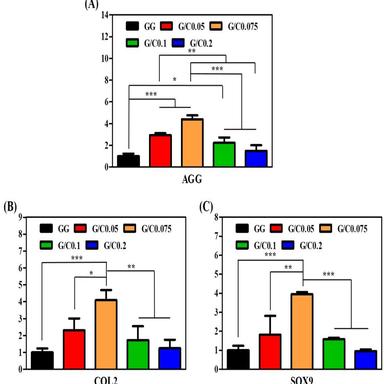
RT-PCR analysis of (A) AGG (B) COL2 and (C) SOX9 normalized by GAPDH (values are mean ± SD, n = 3, P b 0.05 (\), P b 0.01 (\\), P b 0.001 (\\\)).